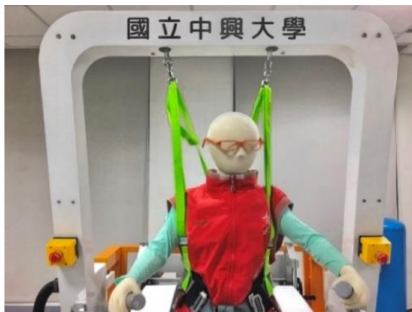
Figure 2. Photo of the PBWSS.